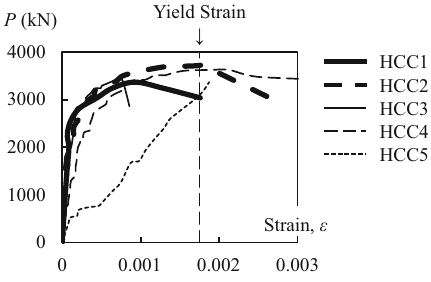
Fig. 8 Definitions of yield displacement, ultimate displace- ment, and energy absorption capacity.